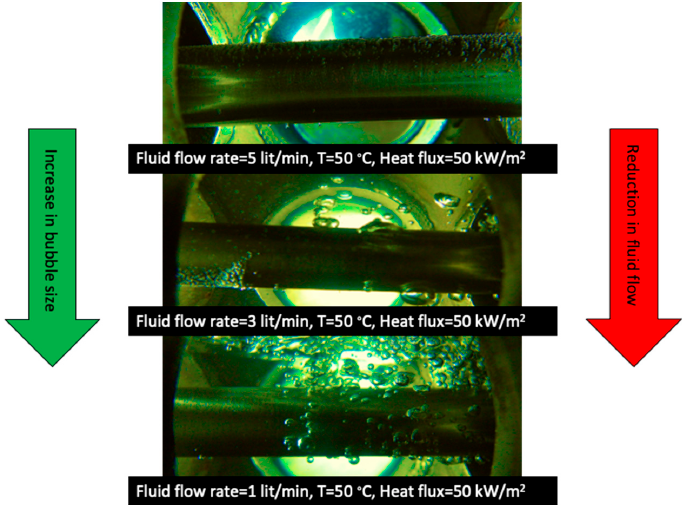
Figure 9. The effect of the fluid flow rate on the average bubble diameter and bubble formation rate on the heating surface at 50 °C.